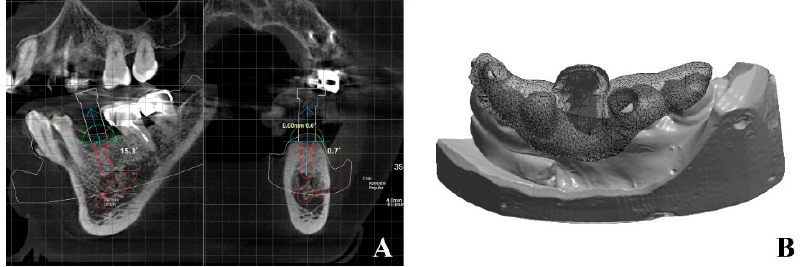
Figure 2. Design of the implant surgical guide. ( A ) Planned implant position with preoperative radiographs. ( B ) virtual surgical guide.